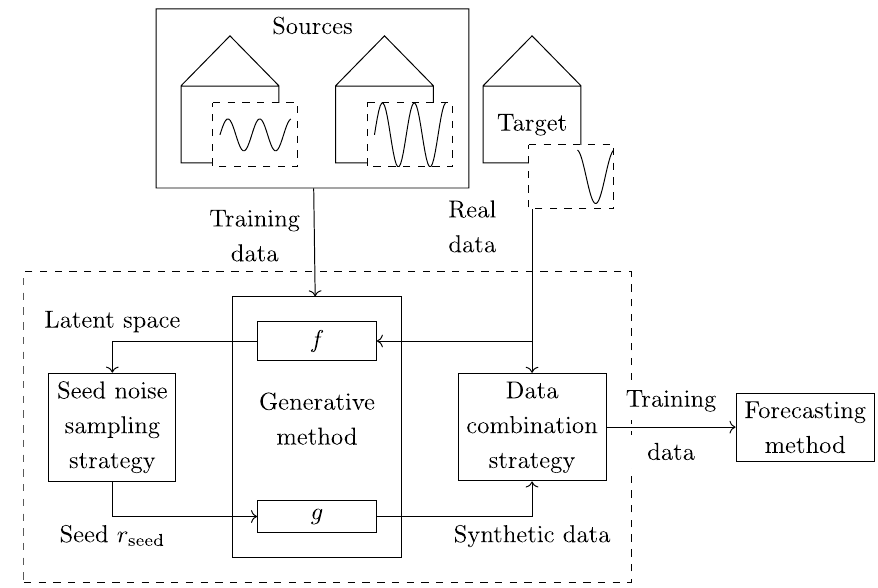
Fig. 1 The LSFE (dashed) consists of three components, i.e. the generative method with the mappings f and g , the seed noise sampling strategy, and the data combination